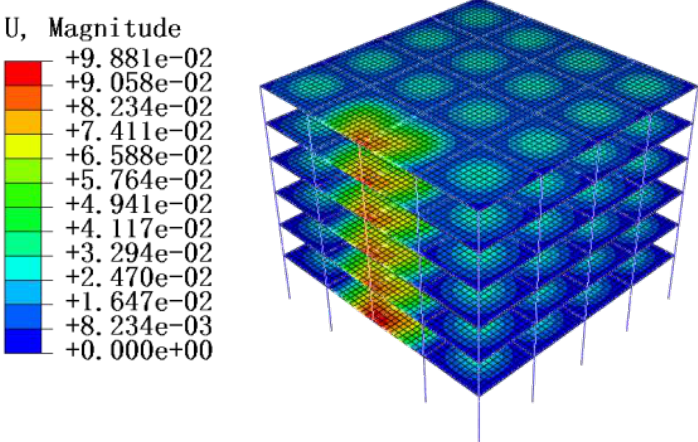
Figure 10. The most unfavorable combination displacement diagram of the bottom side column.